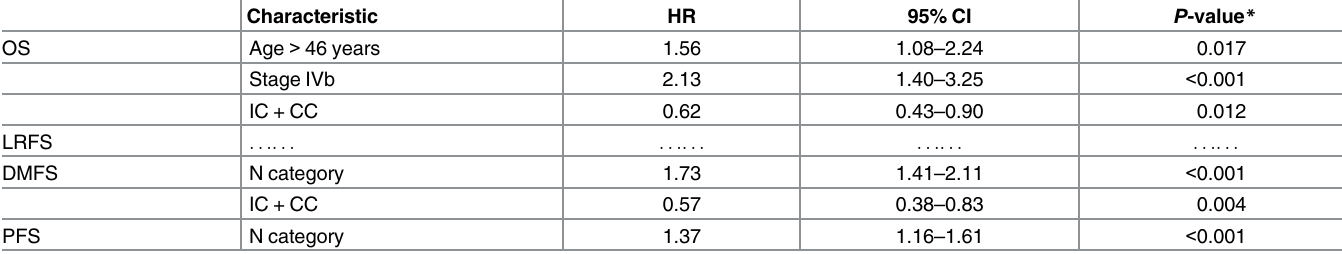
Table 4. Summary of multivariate analysis of prognostic factors in the 602 patients with stage IVa-b nasopharyngeal carcinoma. Characteristic